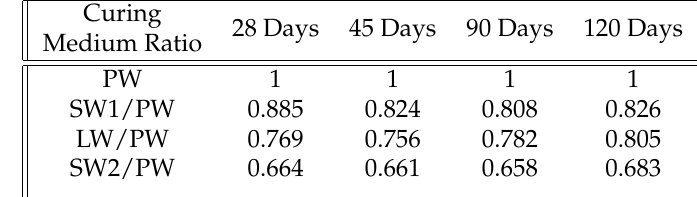
Table 8. Curing medium factor ( α ) for flexural strength at each curing age